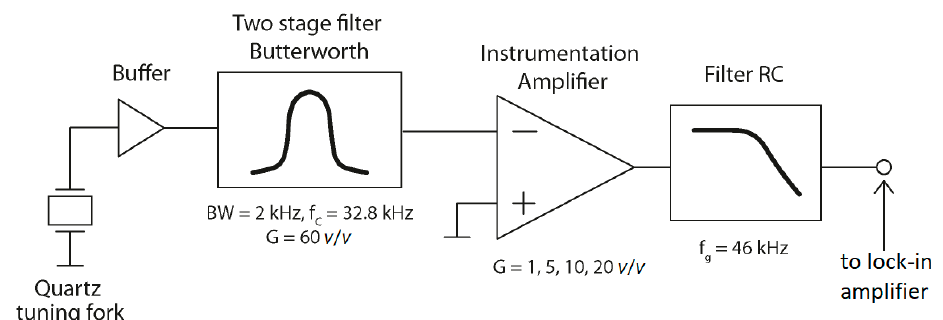
Figure 2. Block diagram of the amplifier used in the experiment. BW—bandwidth; f c —central frequency; G—gain; f g —cut-off frequency of the RC filter.